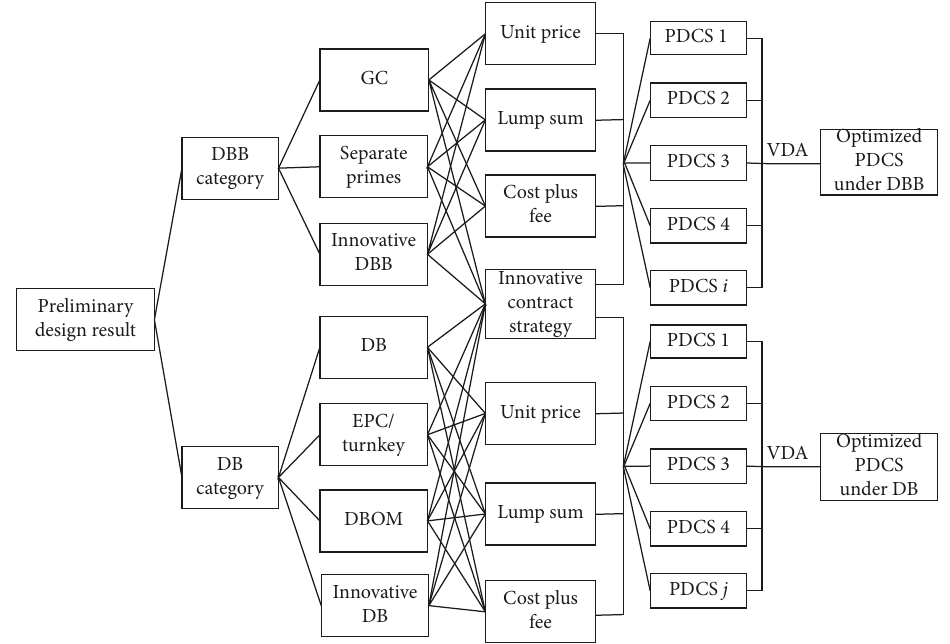
Figure 9: Steps for the detailed design of